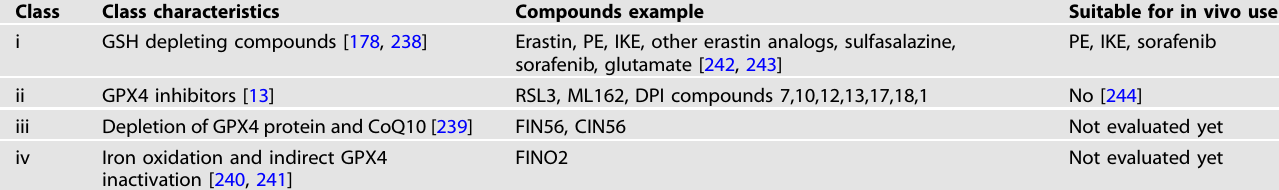
Table 2. Ferroptosis inducers